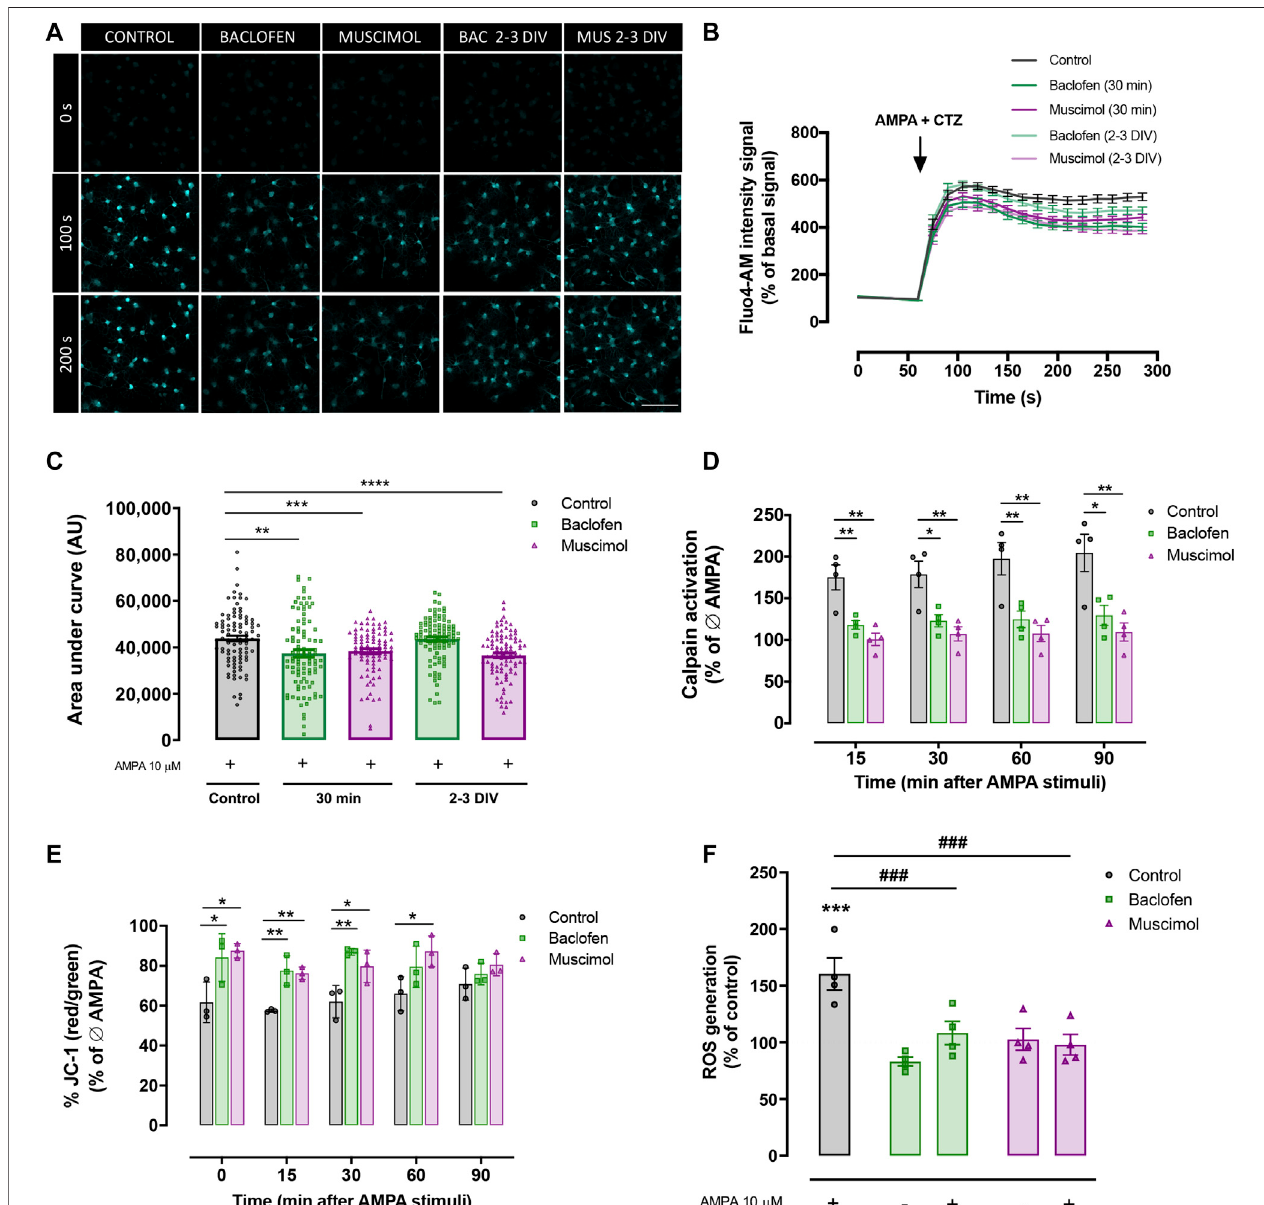
FIGURE 3 | Baclofen and muscimol modulate AMPA-induced calcium signaling and mitochondrial alterations . (A) Representative images of Ca2+ responses to CTZ and AMPA in cells loaded with Fluo4-AM at 0 s, 100 s and 200 s of recording. (B) Recordings of Ca2+ responses to CTZ and AMPA in control oligodendrocytes(blacktrace),treatedwithbaclofenormuscimolfor30minbeforeexposuretoAMPA(greenandmagentatracesrespectively,bold)ortreateddailywith baclofen or muscimol until the analysis (green and magenta traces respectively, soft). (C) Area under the curve of calcium recordings for each condition. Data are shown as violin plots indicating the median and quartiles of at least 88 cells from 4 independent experiments. **p < 0.01, ***p < 0.001, ****p < 0.0001 vs. control; one-way ANOVA. (D) Calpain activity detected using the Calpain-Glo Protease Assay in oligodendrocytes treated with baclofen or muscimol 30 min pre-AMPA and analyzed 30 min after CTZ and AMPA stimulus. All conditions were normalized to controls without AMPA treatment. Data are shown as the mean mean ± SEM of 4 independent experiments. *p < 0.05, **p < 0.01 vs. control; one-way ANOVA. (E) Mitochondrial membrane potential monitored in oligodendrocytes loaded with JC-1 probe. All conditionswerenormalizedtocontrolswithoutAMPAtreatment.Dataareshownasthemean±SEMof3independentexperiments.*p < 0.05,**p < 0-01vs.control;one- way ANOVA. (F) Intracellular levels of ROS in oligodendrocytes treated with baclofen or muscimol for 30 min before adding AMPA and analyzed 30 min after AMPA stimulus. Cell were loaded with CM-H2DCFDA probe and the values were normalized with calcein signal. All conditions were normalized to control values in cultures withoutAMPAtreatment.Dataareshownasthemean±SEMof4independentexperiments.***p < 0.001vs.controlØAMPA;###p < 0.001vs.control;one-wayANOVA.